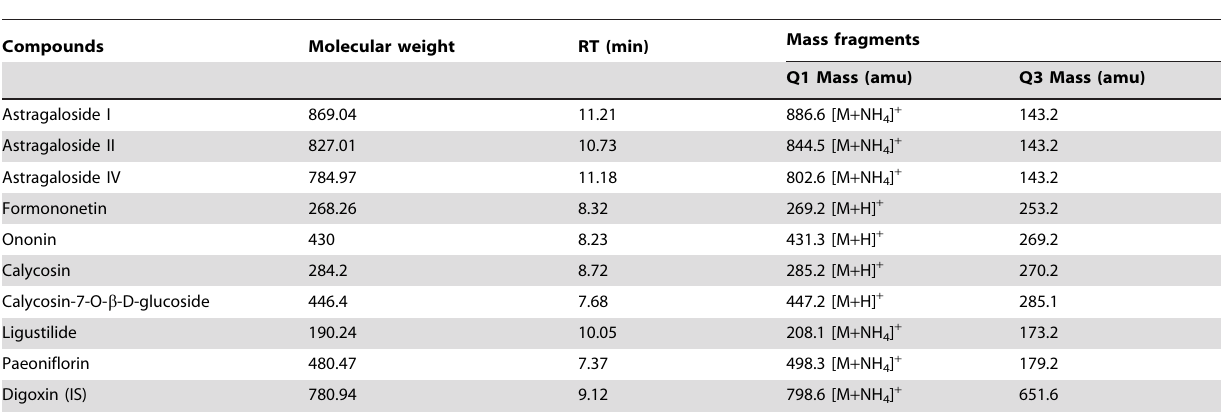
Table 1. The analytical condition of LC-MS/MS for the identification of the nine compounds and internal standard.